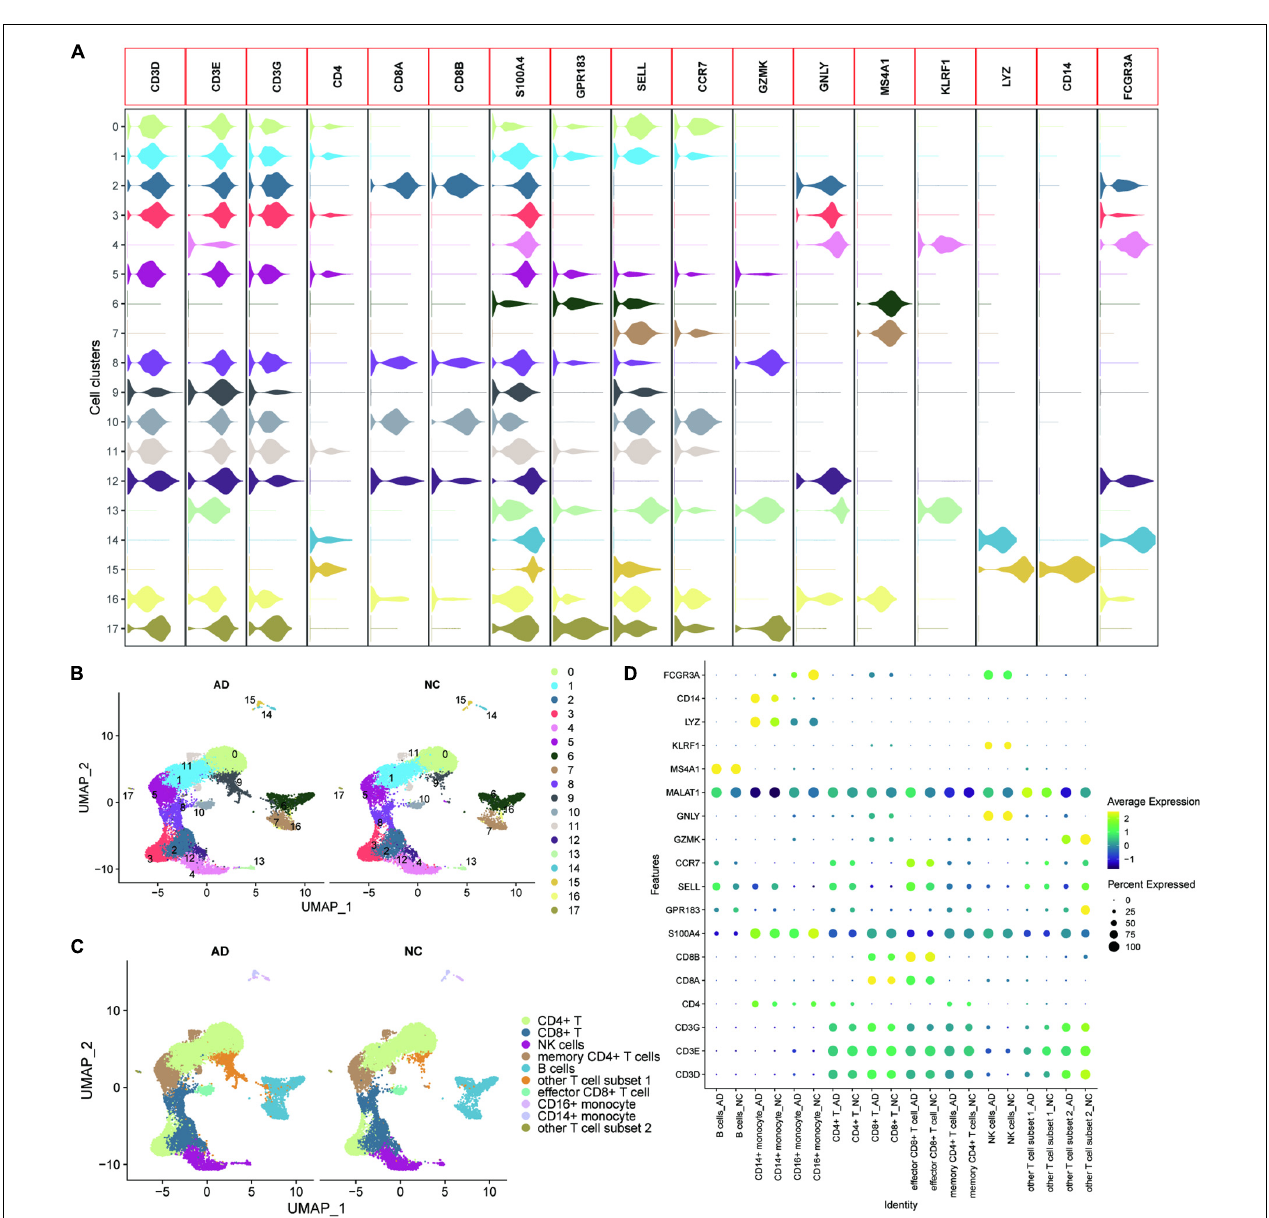
FIGURE 1 | Heterogeneity of the transcriptome of peripheral blood nucleated cells from patients with AD. (A) Violin plots showing the expression of the marker genes in different cell clusters; (B) UMAPs show the distribution of the 17 cell clusters in the AD and NC groups, with different colors representing different cell clusters; (C) The cells are annotated according to the expression characteristics of the cell clusters and marker genes; (D) The dotted heat map showing good agreement and characteristic expression of marker genes between AD and NC groups, where MALAT1 as a characteristic gene of other T cell subset 1 was significantly upregulated in other T cell subset